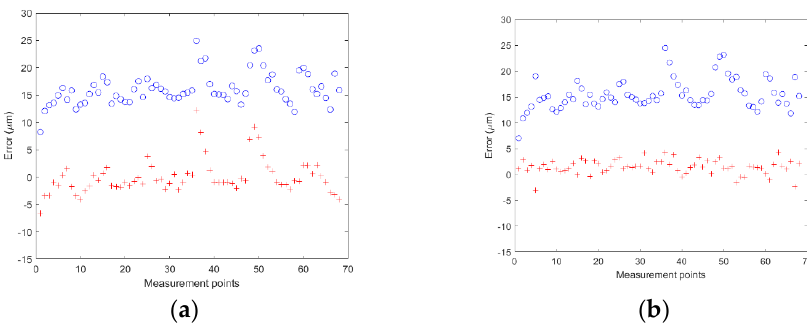
Figure 12. ( a ) The error distribution of replica one before (blue circles) and after (red plus signs) tool radius compensation for Surface three; ( b ) the error distribution of replica one before (blue circles) and after (red plus signs) mirror compensation for Surface three.